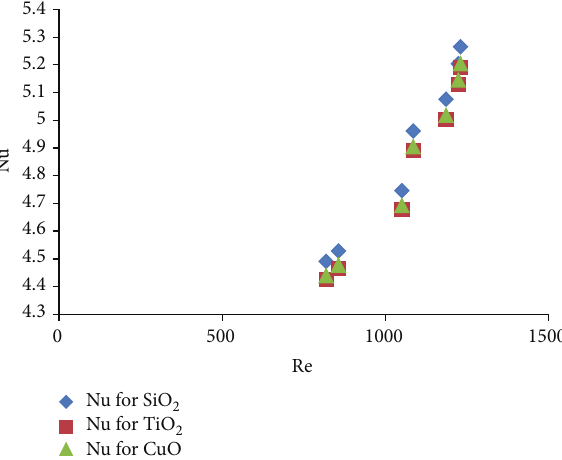
Figure 9: Nusselt number versus Reynolds number for 0.87 mm ID- tube and 3%